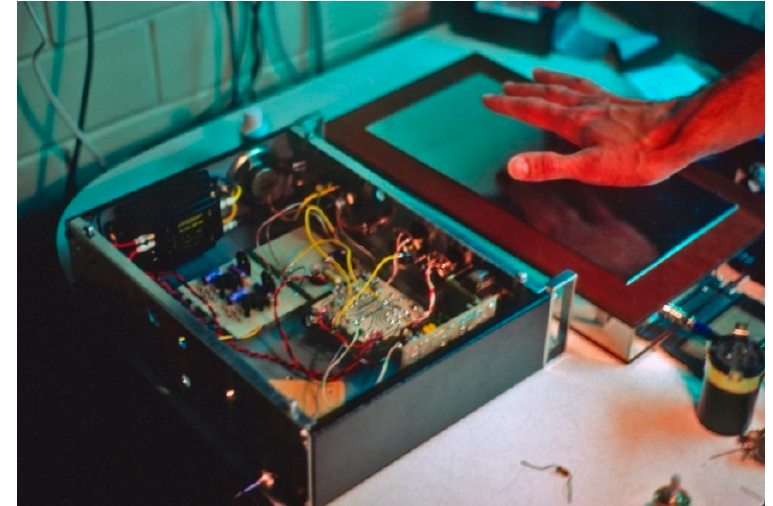
Figure 12. Internal view of Ostoja’s theremin showing electronics. Published with permission. Image courtesy Russell Dahms.